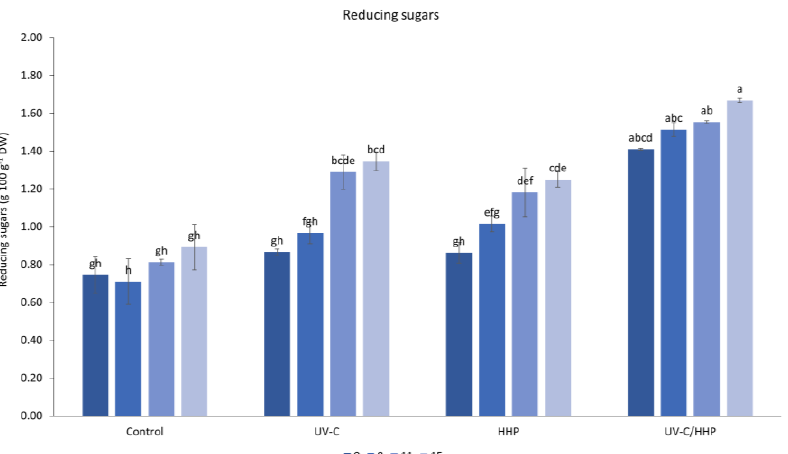
Figure 3. Interaction of treatment (control, UV-C, HHP, and UV-C/HHP) and storage time on reducing sugars. Error bars represent standard errors; lowercase letters represent a significant difference within means ( p < 0.05).